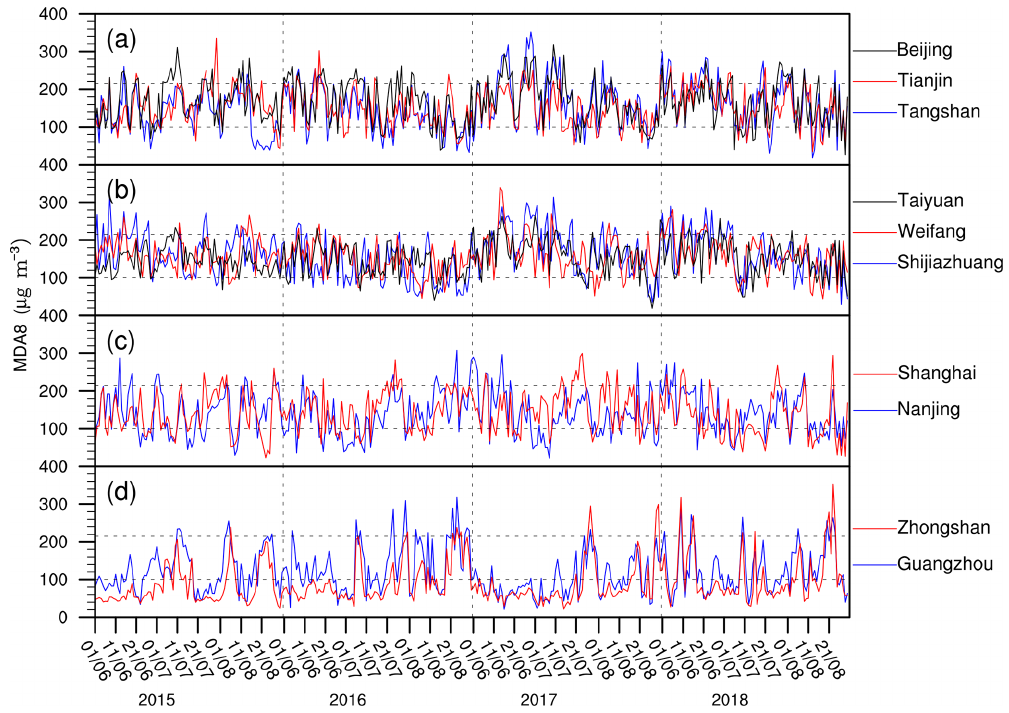
Figure 3. Variations in MDA8 (unit: µgm − 3 ) of polluted cities from 2015 to 2018, including (a) Beijing (the capital of China), Tianjin, and Tangshan near the capital city; (b) Taiyuan, Weifang, and Shijiazhuang in the south of NCH; (c) Shanghai and Nanjing in the YRD; and (d) Zhongshan and Guangzhou in the PRD. The cities in (a) – (d) are located from north to south and are illustrated in Fig. S2. The horizontal dashed lines indicate the value of 100 and 215µgm − 3